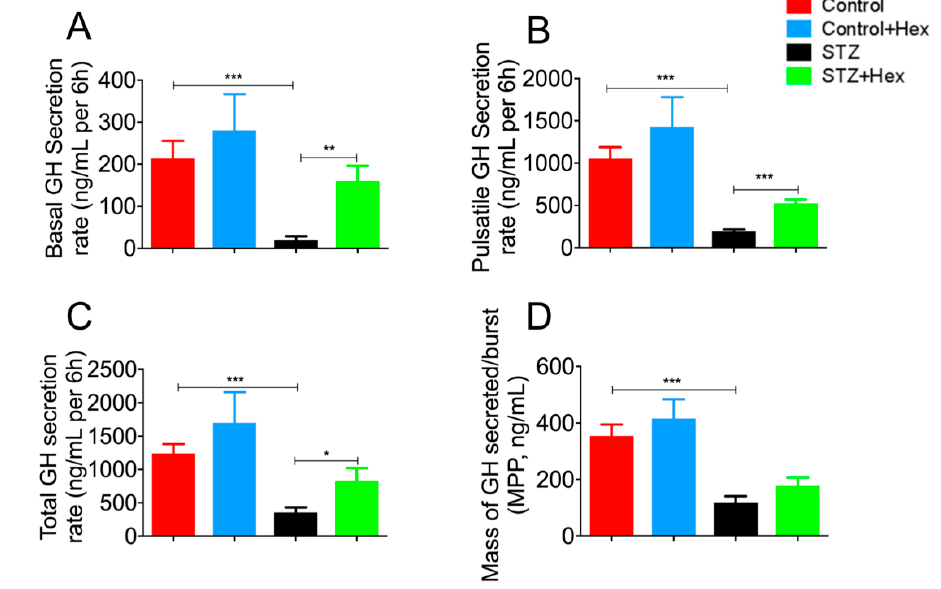
Figure 2. Deconvolutional analysis of pulsatile GH secretion from control, control + Hex, STZ, and STZ + Hex rats. ( A ) Basal, ( B ) pulsatile, ( C ) total, and ( D ) the mass of secreted per burst were determined by deconvolutional analysis. n = 16, data are shown as the mean ± SEM. * p < 0.05, ** p < 0.01, *** p < 0.001.